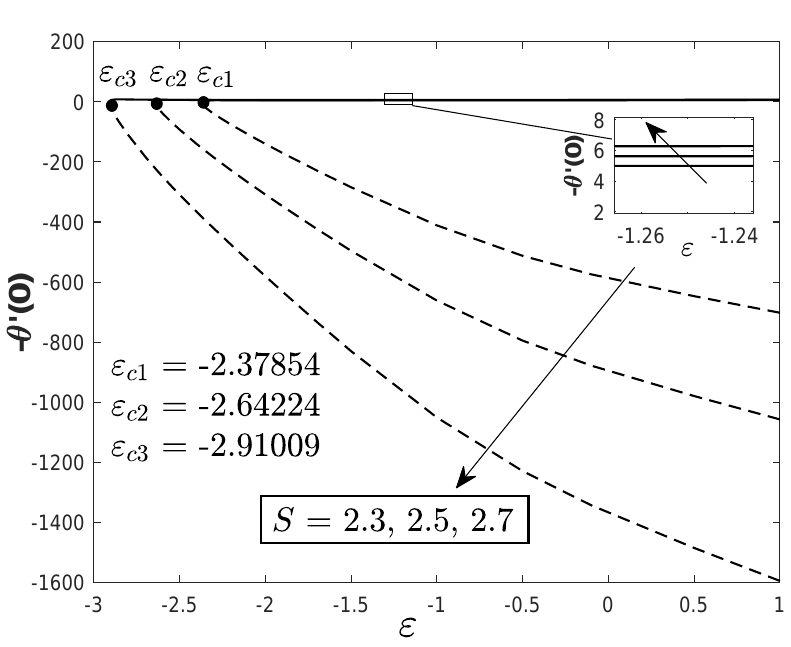
Figure 3. − θ (cid:48) ( 0 ) versus ε for various values of suction S